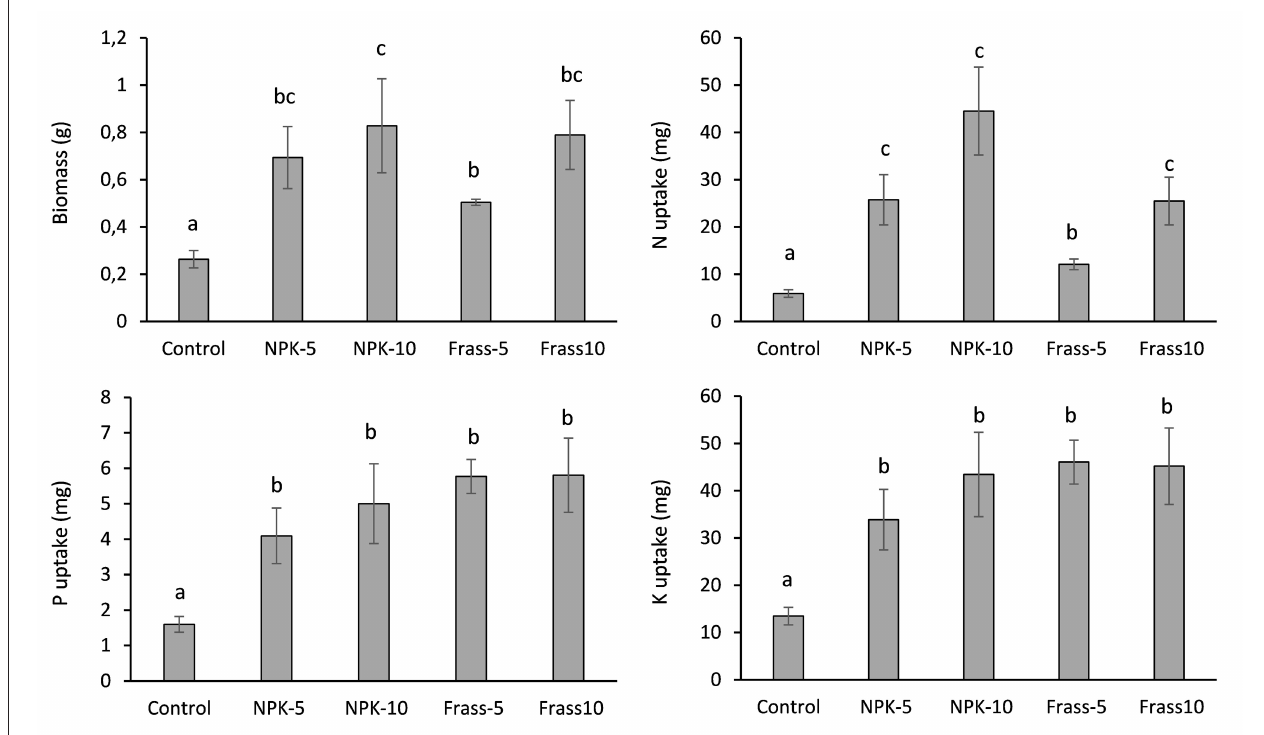
FIGURE 1 | Biomass and uptake of N, P and K of ryegrass. Values are average ( n = 4) ± standard error. Columns with same letter do not differ significantly at the 5% level.